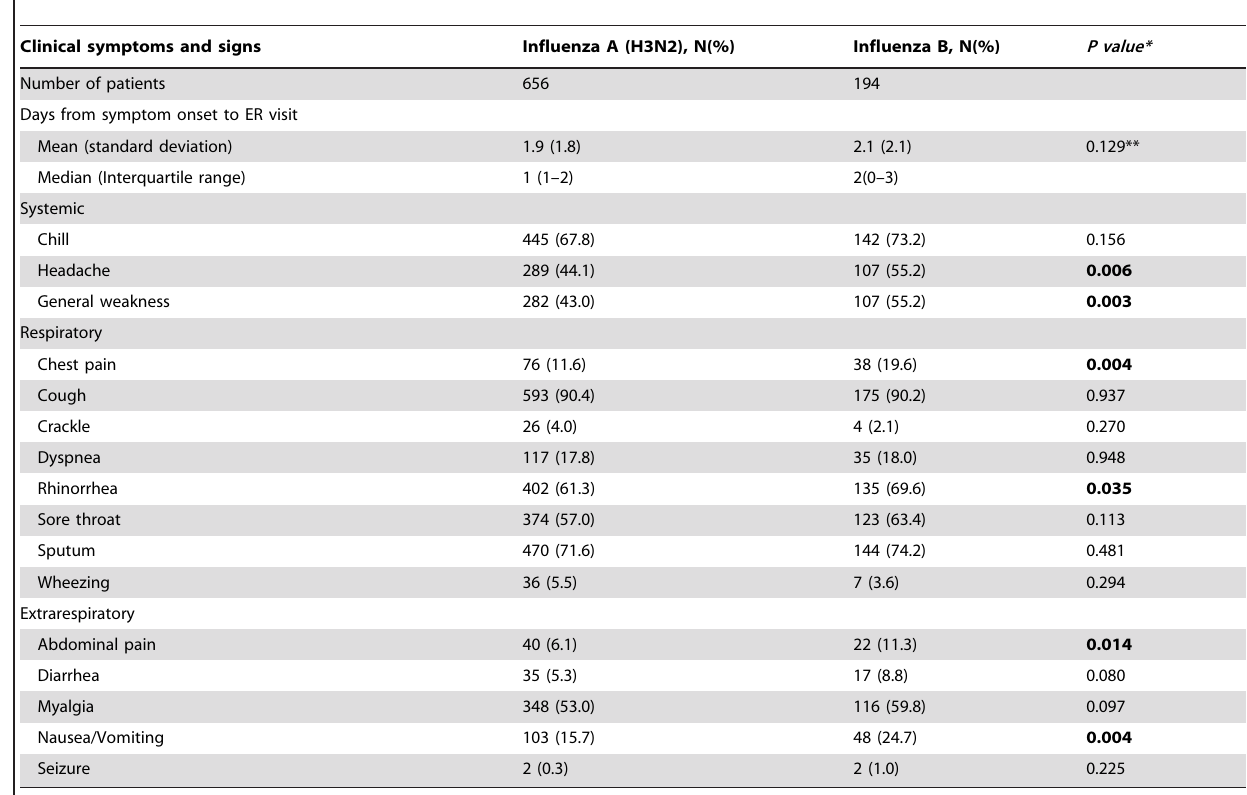
Table 2. Clinical symptoms and signs of patients with laboratory-confirmed Influenza A (H3N2) and Influenza B from October 2011 to May